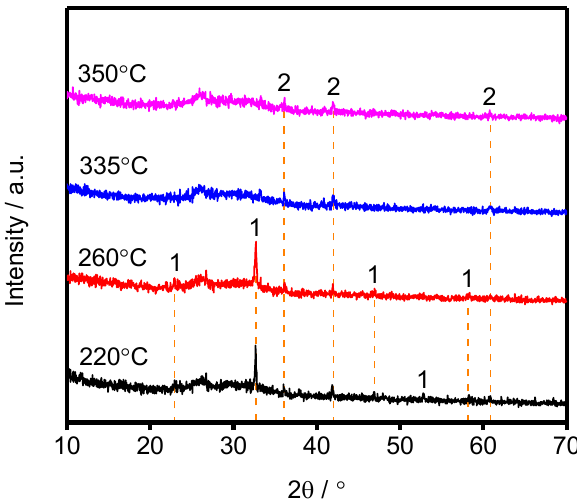
Figure 8: XRD patterns of the calcined product obtained at different temperatures: 1- Ammonium Chloride, 2- Titanium Carbide.